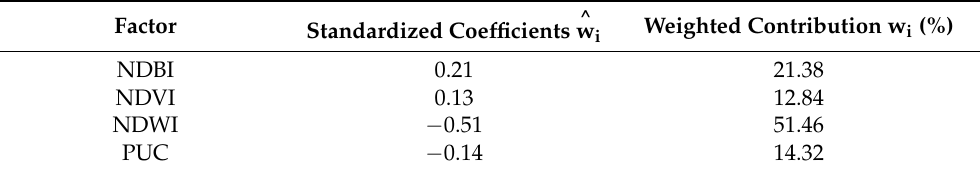
Table 5. Standardized Regression Coefficients and Contribution of each